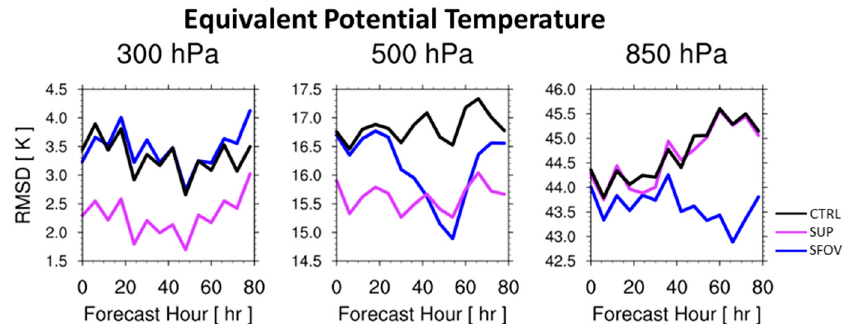
Figure 7. Statistics of the forecast performance of equivalent potential temperature at 300 ( left panel), 500 ( middle panel) and 850 ( right panel) hPa pressure levels for CTRL ( black curves), SUP ( purple curves) and SFOV ( blue curves) experiments.